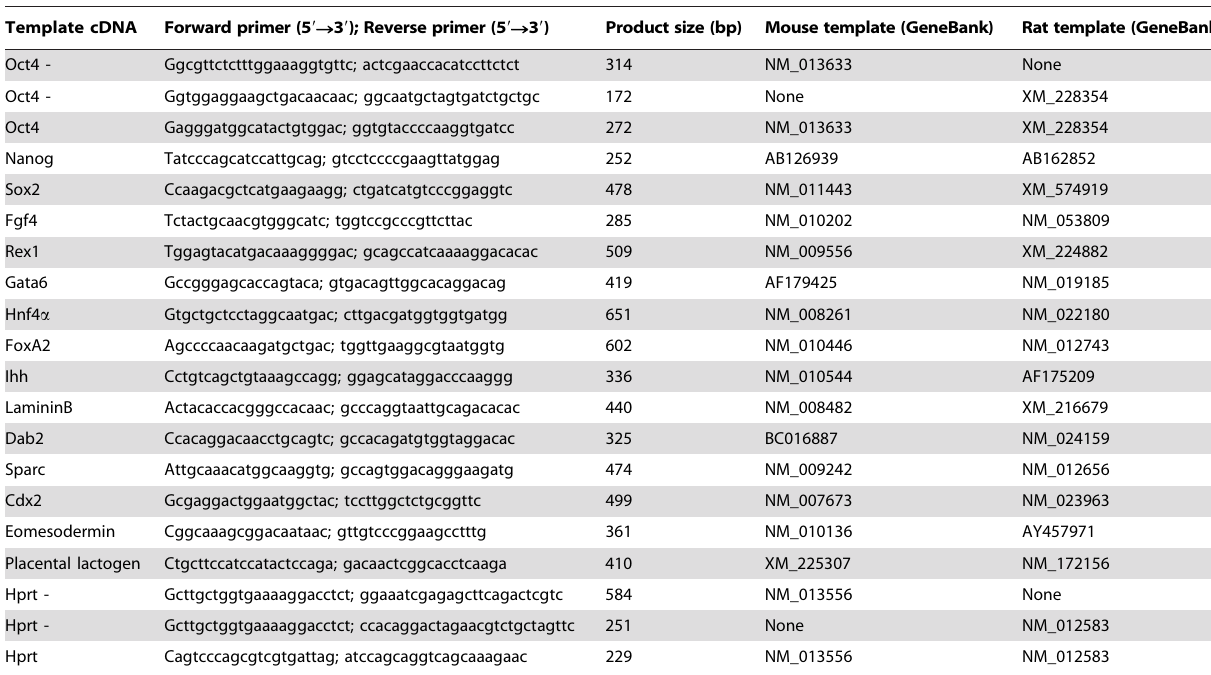
Table 3. List of primers used in this